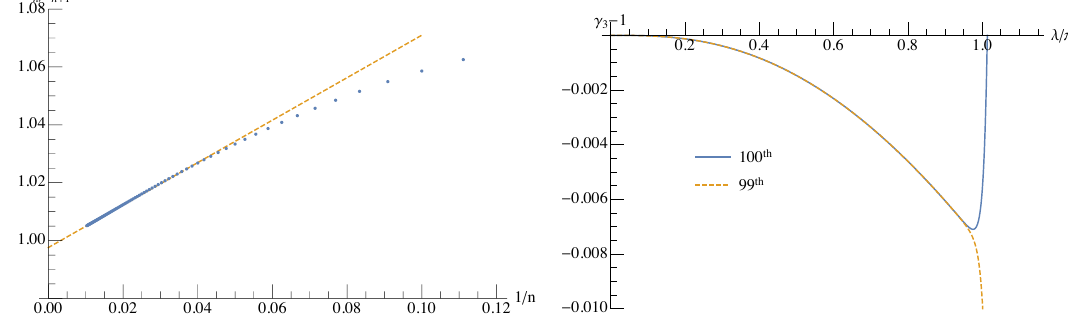
Figure 8 . (Left) The Domb-Sykes plot to estimate of the radius of convergence R by ratio test c n =c n +1 . The intercept of the linear asymptote is 0.997, very close to 1. (Right) The 99 th and 100 th -order truncated Taylor polynomials of (cid:1) (cid:13) 3 .